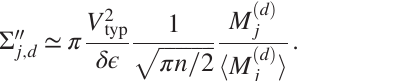
r ffiffiffiffiffiffiffiffiffiffiffiffiffiffiffi π σ ; ð 95 Þ ¼ M 4 log M